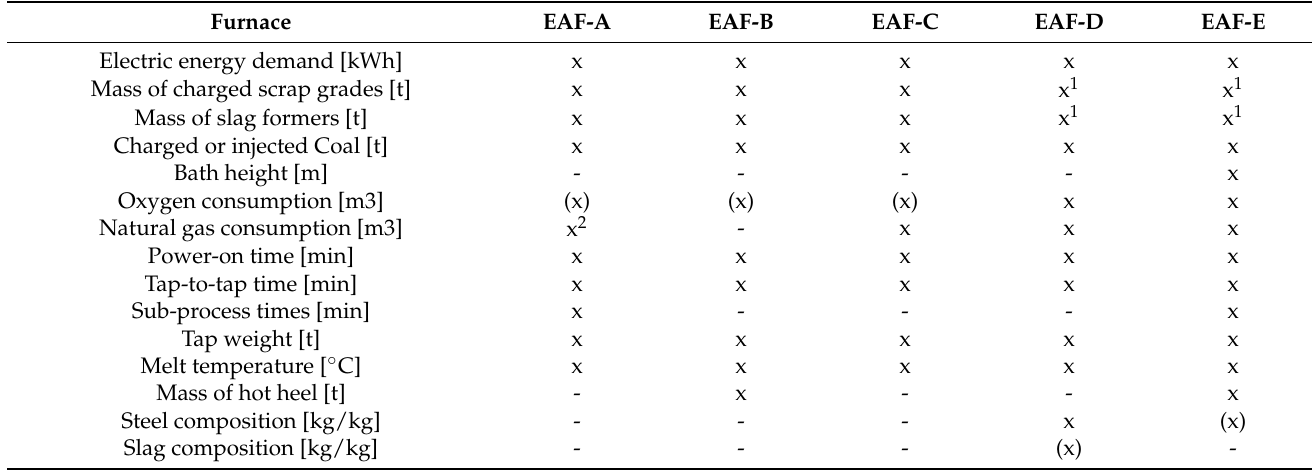
Table 3. Overview of the available measurements at the investigated